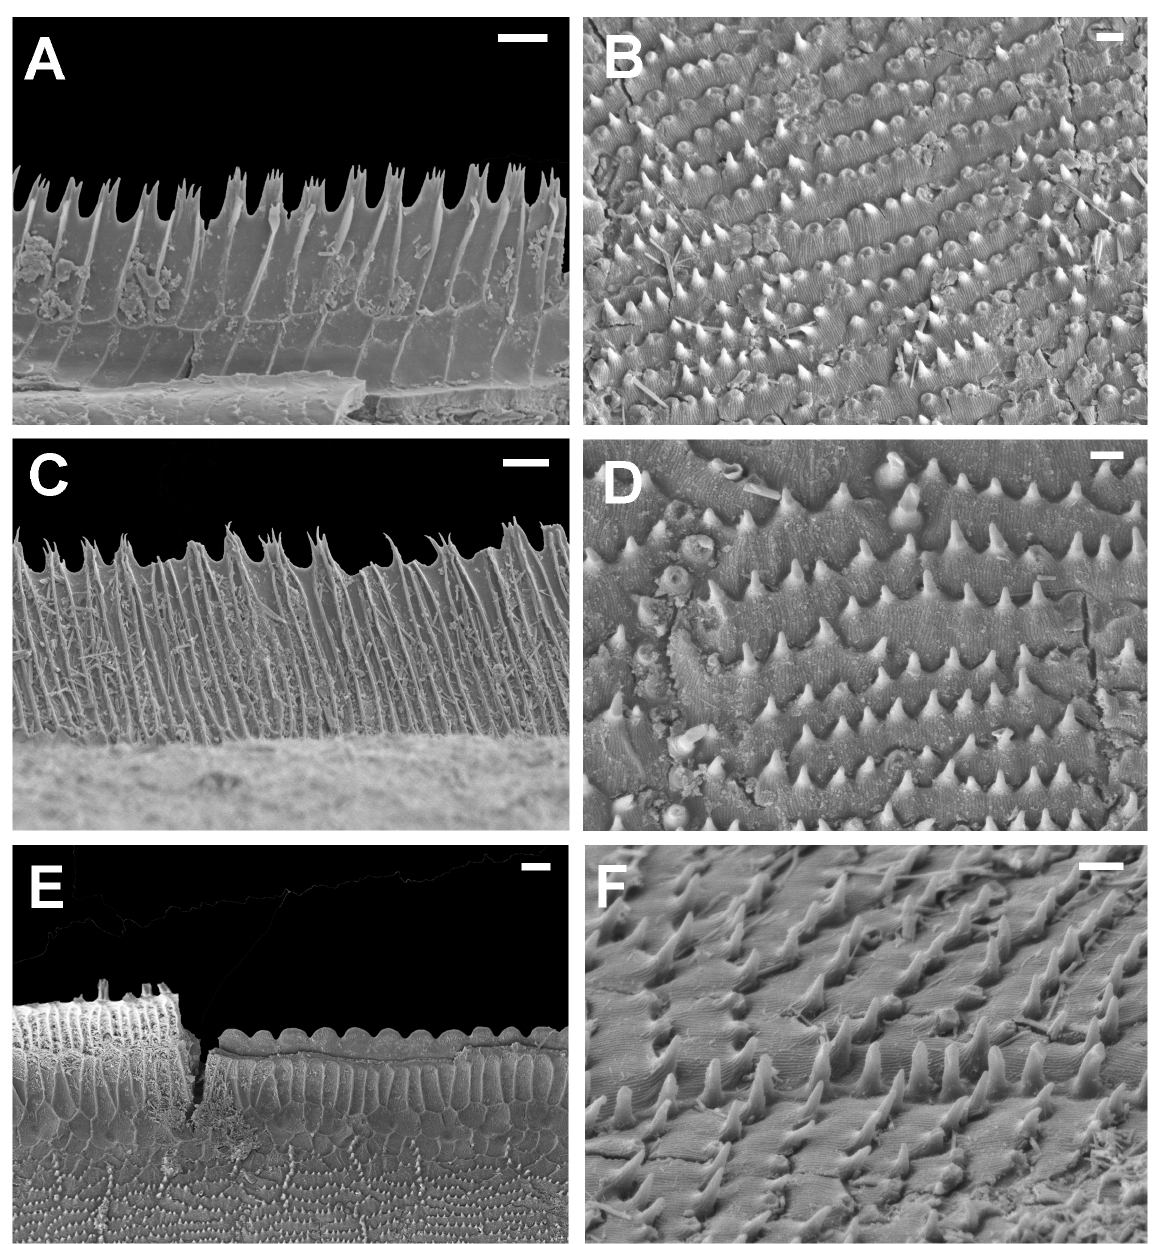
Fig. 4. Helicochetus spp., ♂♂, from Udzungwa Mts. A–B . H. dimidiatus (Peters, 1855). C–F . H. mutaba Kraus, 1960. A, C, E . Limbus; in E the limbus proper is damaged (remains are seen to the left), so the round-lobed “sublimbus” becomes visible. B, D, F . Surface microsculpture of limbus. Scale bars: A, C, E = 0.01 mm; B, D, F = 0.002